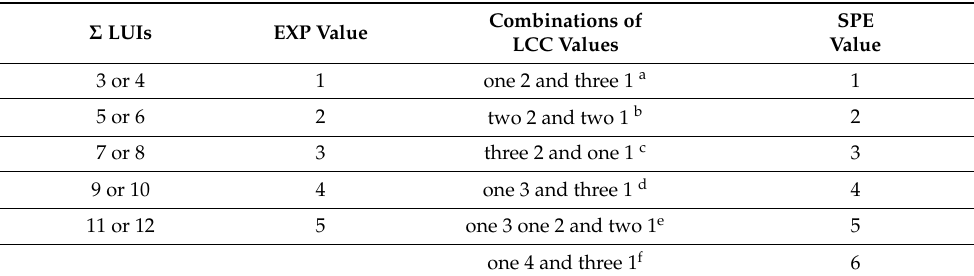
Table 3. The method used to calculate EXP and SPE indices starting from the indicator (LUI and LCC)